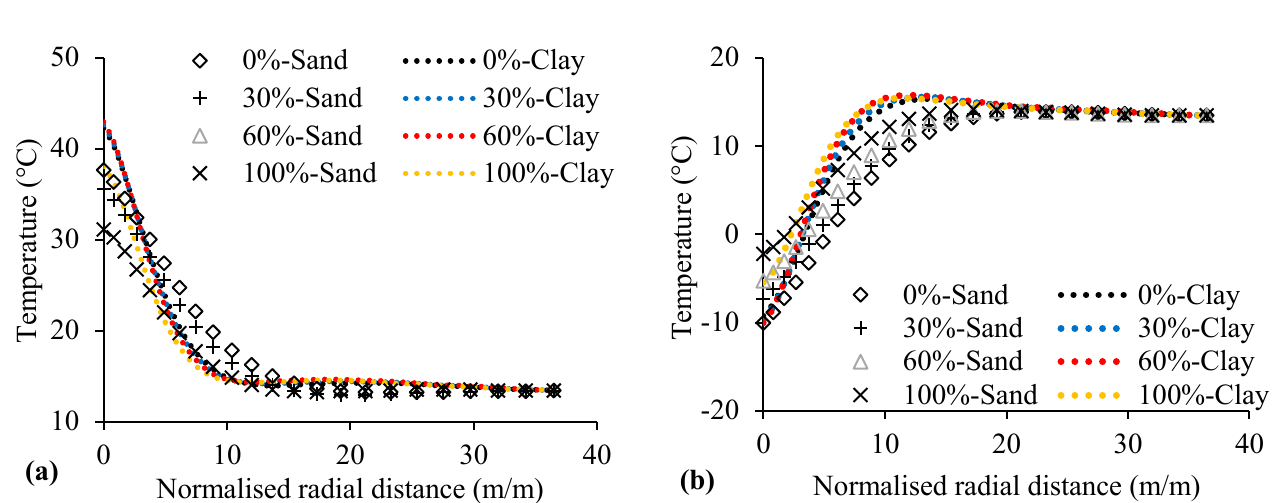
towards the far-field boundary to the right, located at a distance of 21.9 m (or 36.5